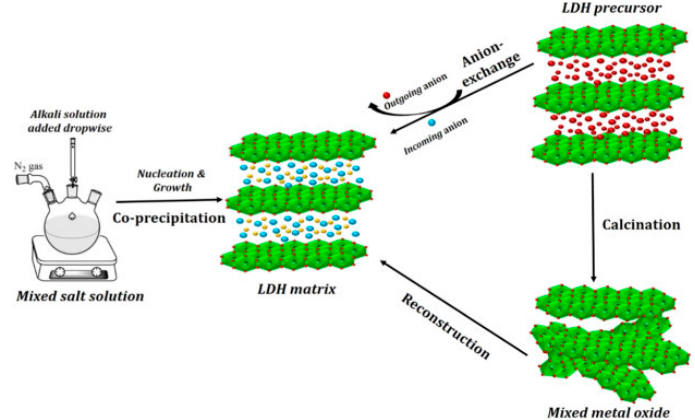
Figure 5. Schematic representation of co-precipitation, ion exchange and reconstruction methods LDH. Reproduced with permission from Reference [59]. Copyrights 2018, Elsevier Science Ltd.